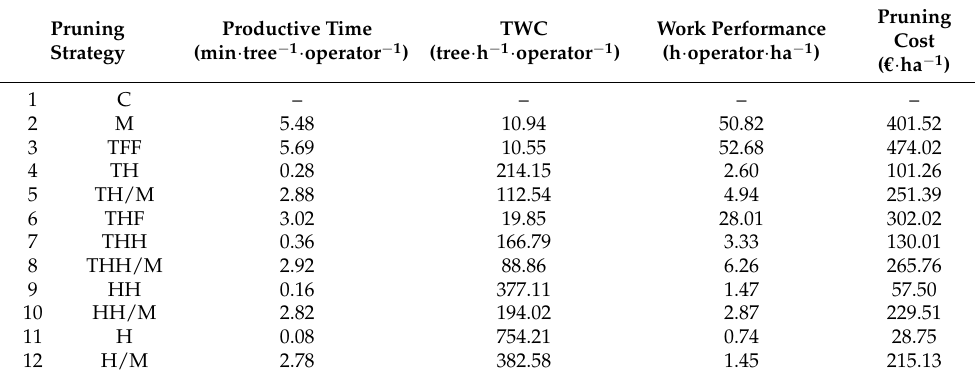
Table 8. Four-year average estimated productive pruning time (min · tree − 1 · operator − 1 ), pruning theoretical working capacity (TWC, tree · h − 1 · operator − 1 ), work performance (h · operator · ha − 1 ),